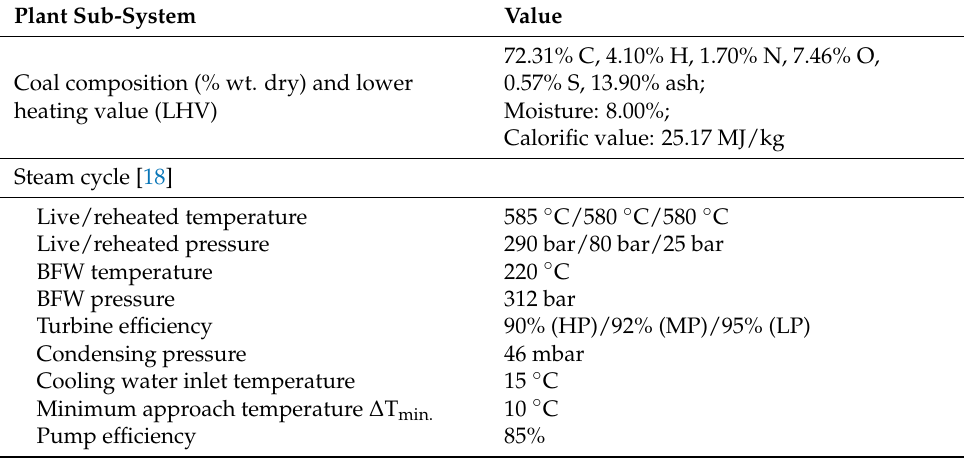
Table 1. Main technical assumptions of evaluated power plants.